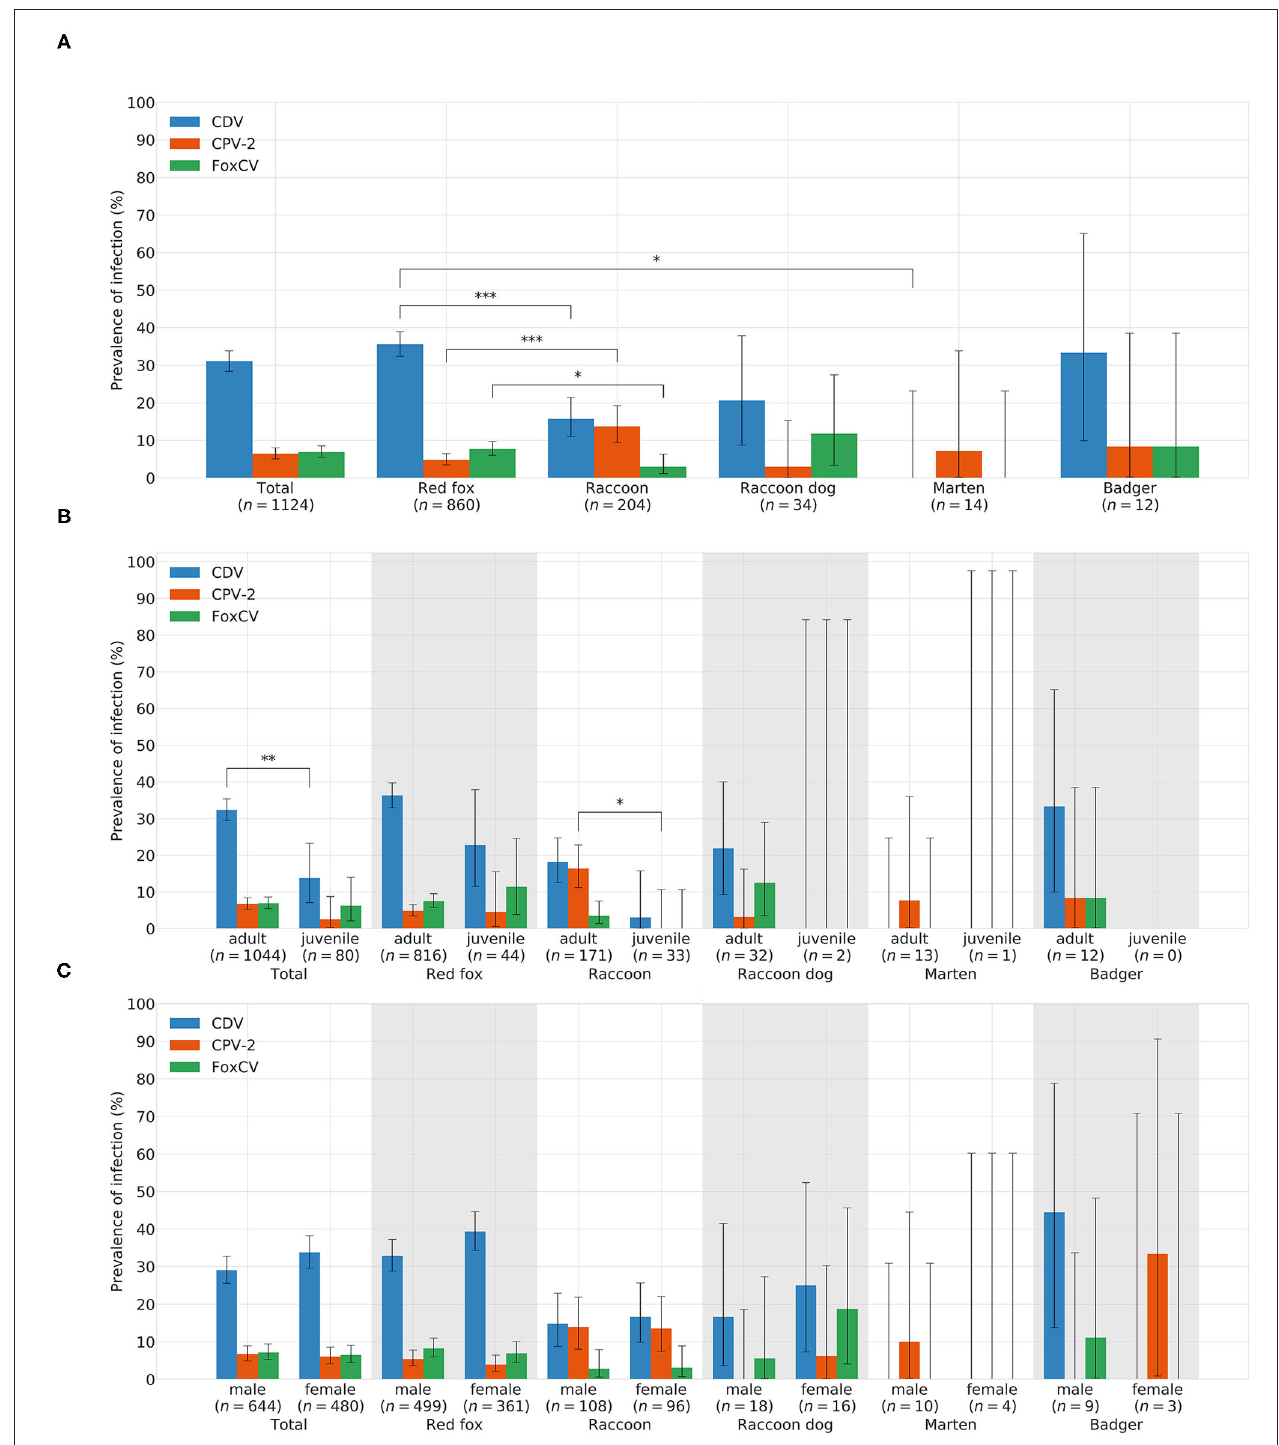
FIGURE 3 | Prevelances of CDV, CPV-2, and FoxCV by (A) species, (B) age, and (C) gender. Error bars indicating 95% confidence intervals (CIs). Significant p -values are indicated as follows: * p ≤ 0.05; ** p ≤ 0.01; *** p ≤ 0.001. Number of animals sent in ( n ).